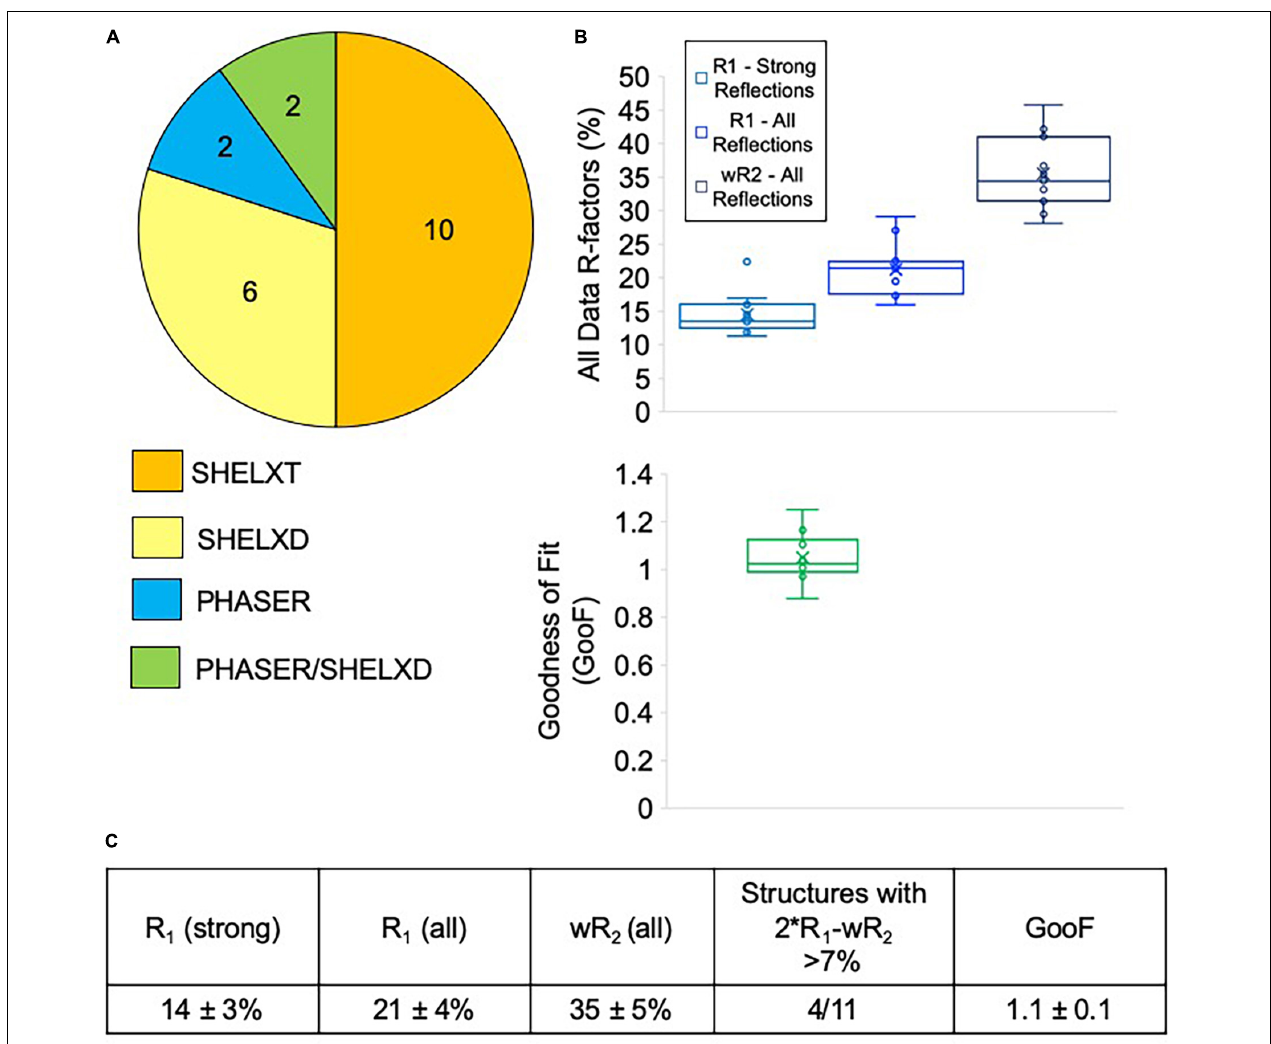
FIGURE 7 | (A) Phasing method used for structures solved at NIS (internal and client samples). Generally, SHELXT was attempted first, followed by SHELXD, followed by PHASER. For two samples, a combination of SHELXD and PHASER were used. (B) Average refinement statistics for structures determined and refined at NIS shown as boxplots. Note that only structures solved with SHELXT and SHELXD are included in this analysis. (C) Average refinement statistics for structures determined and refined at